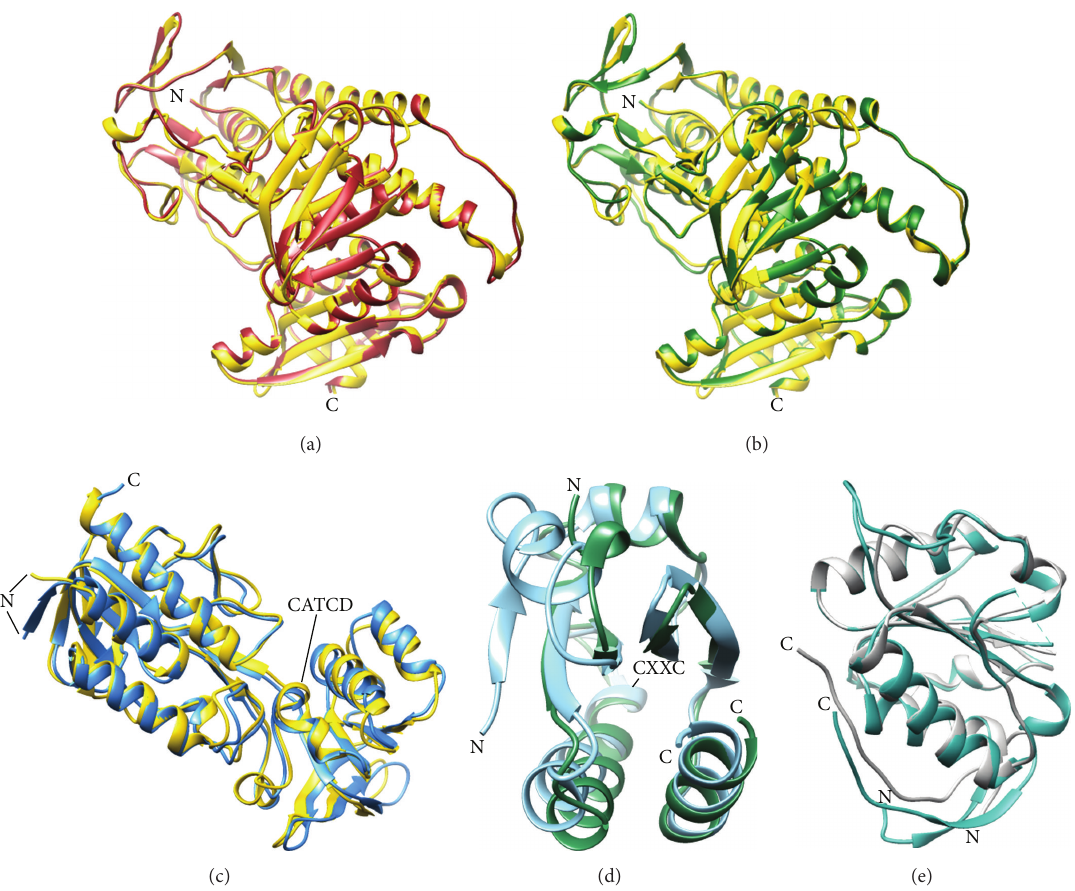
Figure 3: Pairwise structural superposition of T. indiensis proteins with Cr(VI) reduction proteins of different bacteria. (a) T. indiensis LPD1 (brown) with T. scotoductus LPD (gold); (b) T. indiensis LPD2 (green) with T. scotoductus LPD (gold); (c) T. indiensis Tdr (gold) with D. desulfuricans MreE (blue); (d) T. indiensis thioredoxin (blue) with D. desulfuricans thioredoxin (green); (e) T. indiensis indolepyruvate ferredoxin oxidoreductase (blue) with D. desulfuricans MreG (grey). N-termini, C-termini, and redox-active CATCD and CXXC have been